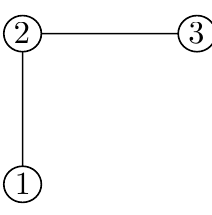
Figure 1. Graph ( N , E )